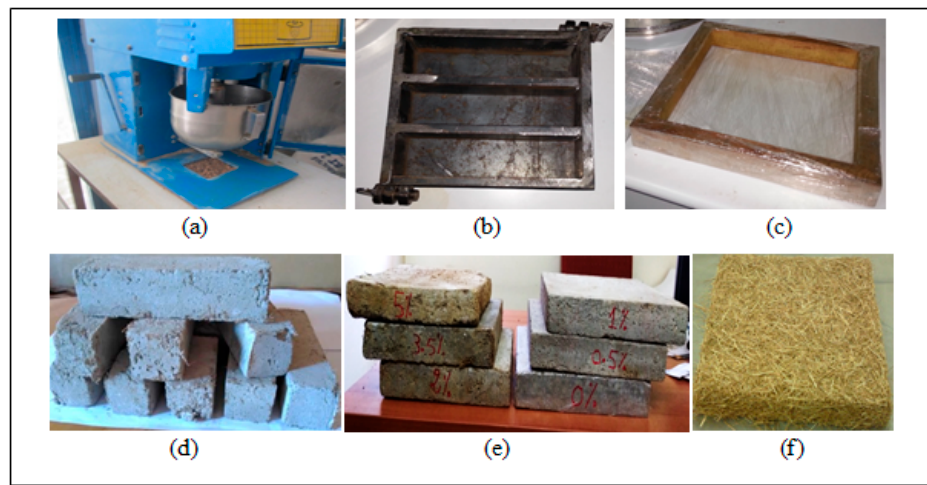
Figure 3. Preparation and manufactured samples: ( a ) mixer, ( b , c ) prismatic and parallelepiped molds, ( d , e ) samples for mechanical and thermal tests and ( f ) AF binderless board.